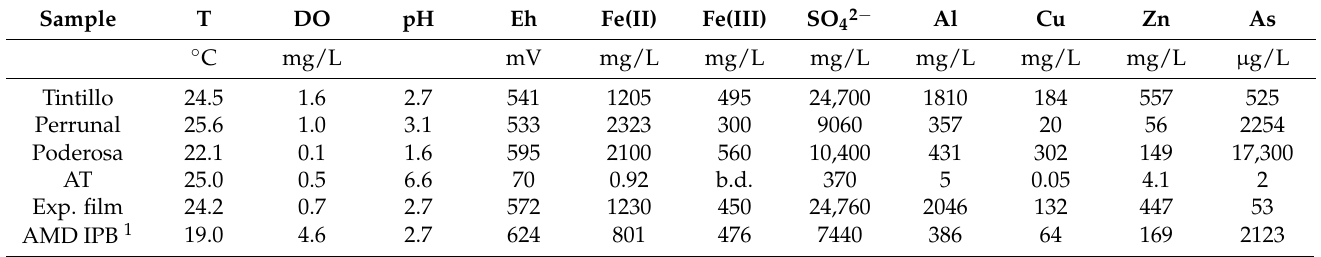
Table 1. Selected physico-chemical parameters and metal concentrations measured in waters co- existing with the studied floating mineral films (all values refer to single measurements in the sampling points).